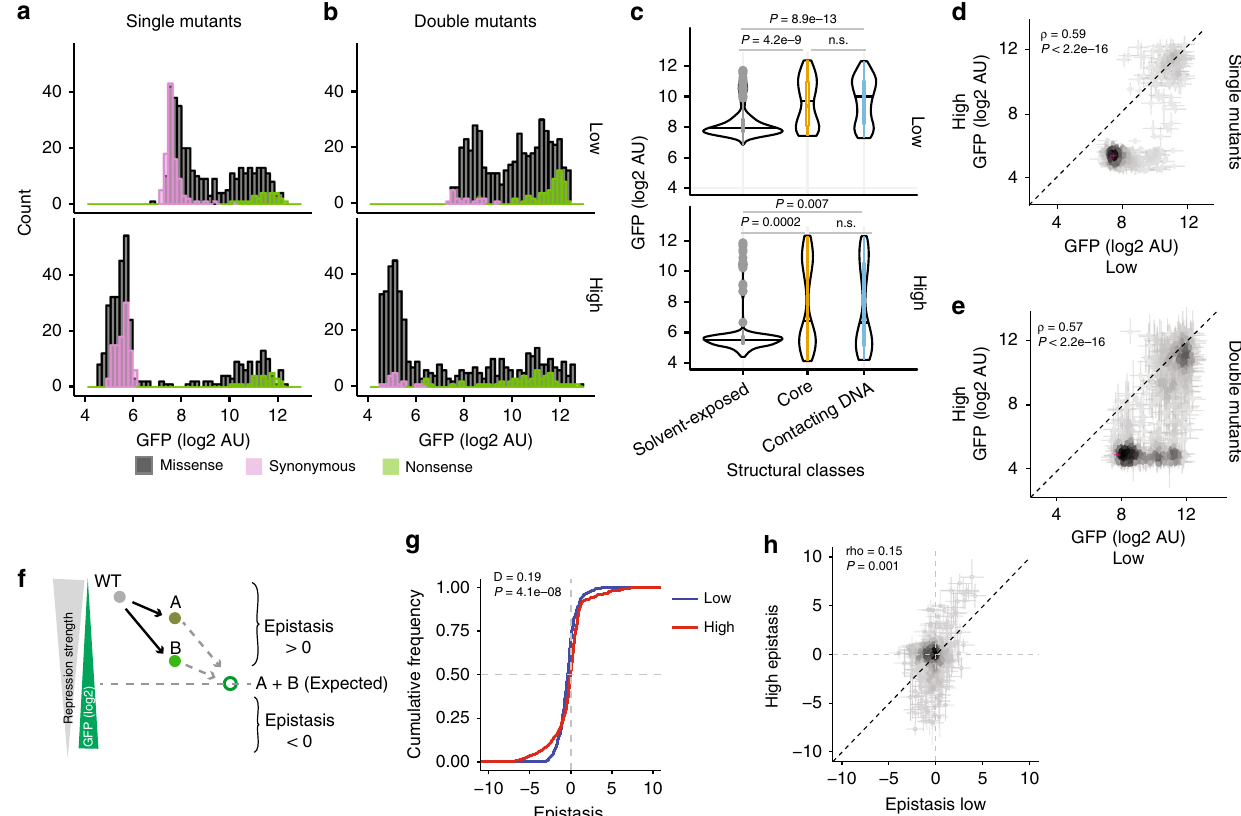
Fig. 2 Comparison of mutational effects and genetic interactions at two expression levels. a , b Histogram of the mean mutational effects of single ( n = 351) ( a ) and double ( n = 468) ( b ) missense amino acid variants together with synonymous ( n = 114 for single, n = 37 for double) and nonsense ( n = 21 for single, n = 47 for double) variants. c Effects of single mutants in different structural regions. Classes compared using Kruskal-Wallis test with post hoc Dunn ’ s test. d , e Comparison of mean mutational effects at the two expression levels. f Log-additive de fi nition of epistasis. g Cumulative distributions of mean epistasis scores at the two expression levels ( n = 468). Distributions compared using two-sample Kolmogorov – Smirnov test. h Mean epistasis scores at the two expression levels. Error bars in d , e , h denote standard error of the